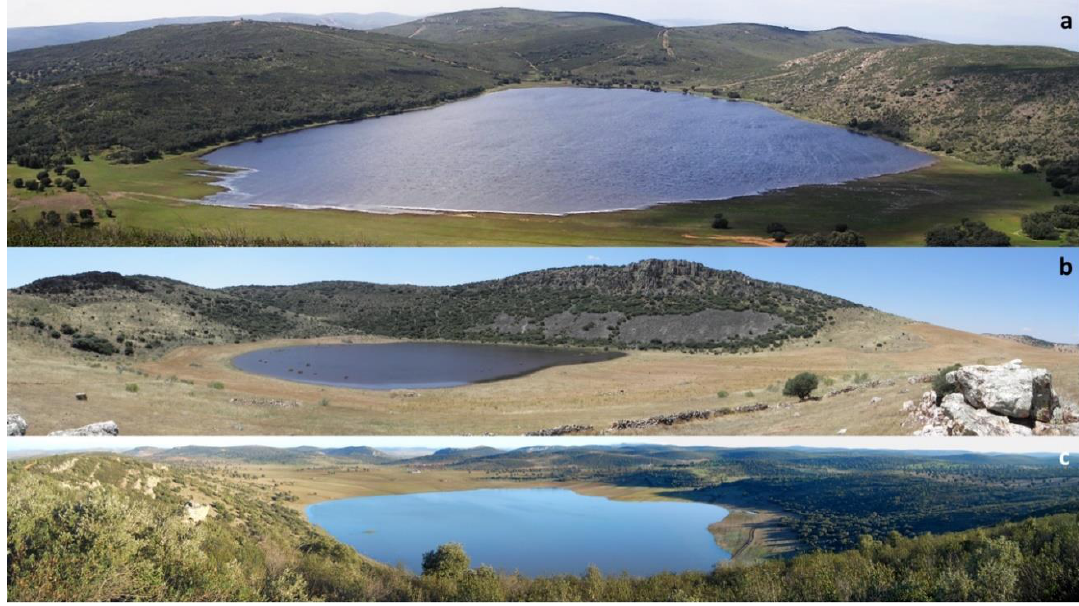
Figure 6. Some examples of maar-diatremes with shallow lakes: ( a ) Las Carboneras (Argamasilla de Calatrava); ( b ) Hoya de Cervera Natural Monument (Almagro); ( c ) Laguna del Acebuche, Calatrava Massif Natural Monument (Almagro).